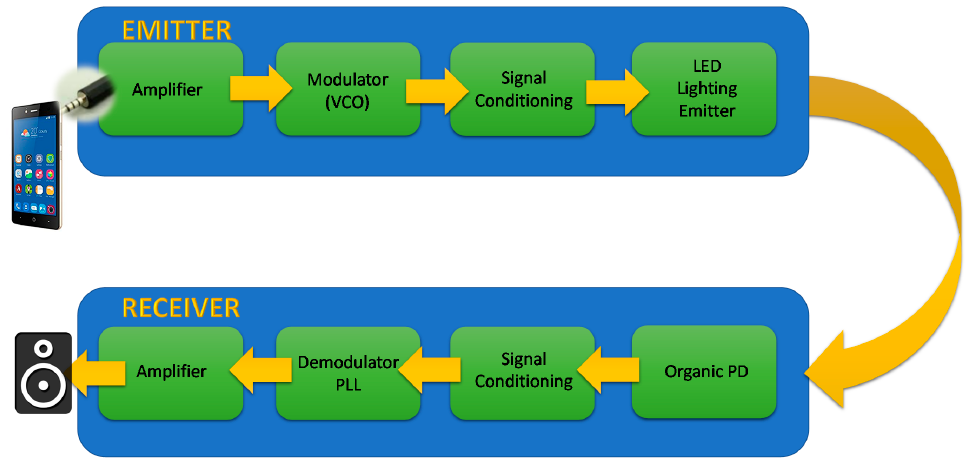
Figure 3. The VLC system block diagram.